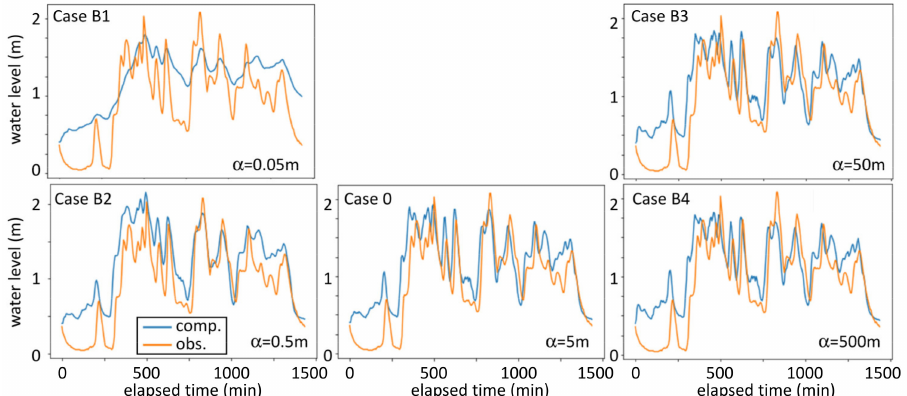
Figure 6. Comparisons of the time-varying water level at the Shin-Yokohama manhole in cases 0, B1, B2, B3, and B4.